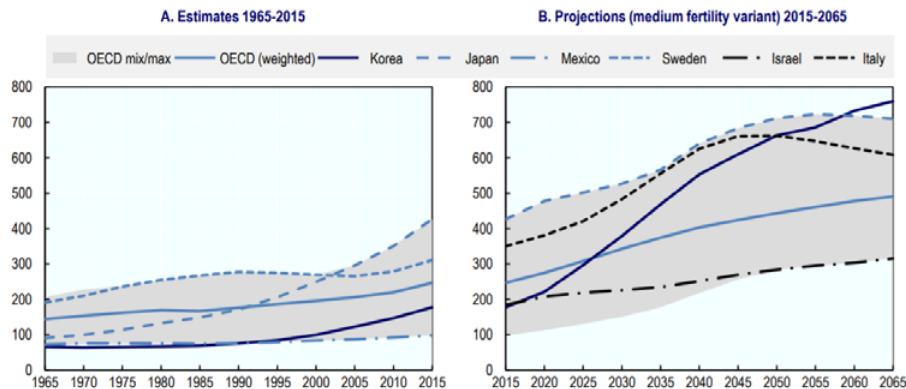
Figure 2. Old age dependency ratio (1965 – 2015, 2015 – 2065). Note: number of people aged 65+ for every 1000 of the working-age population (ages 15 – 64). Source: OECD [6]. Table 1. Estimates of the total population and the elderly in poverty (2019, 2025).